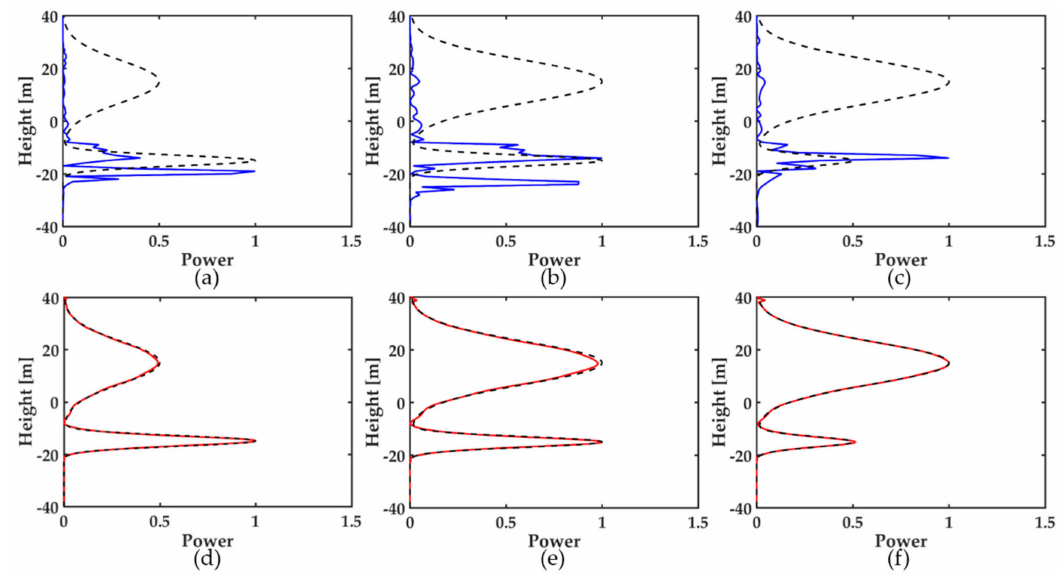
Figure 2. The reconstructed reflectivity profiles by the wavelet-sparse iterative covariance-based estimation (SPICE) and wavelet and orthogonal sparse basis (W&O-SPICE) synthetic aperture radar tomography (TomoSAR) methods for a simulated signal with di ff erent ground-to-canopy power ratios: ( a ) wavelet-SPICE for r > 1; ( b ) wavelet-SPICE for r = 1; ( c ) wavelet-SPICE for r < 1; ( d ) W&O-SPICE for r > 1; ( e ) W&O-SPICE for r = 1; ( f ) W&O-SPICE for r < 1. The black dotted lines are the normalized simulated profiles. The blue solid lines are the reconstructed reflectivity profiles of wavelet-SPICE. The red solid lines are the reconstructed reflectivity profiles of W&O-SPICE.